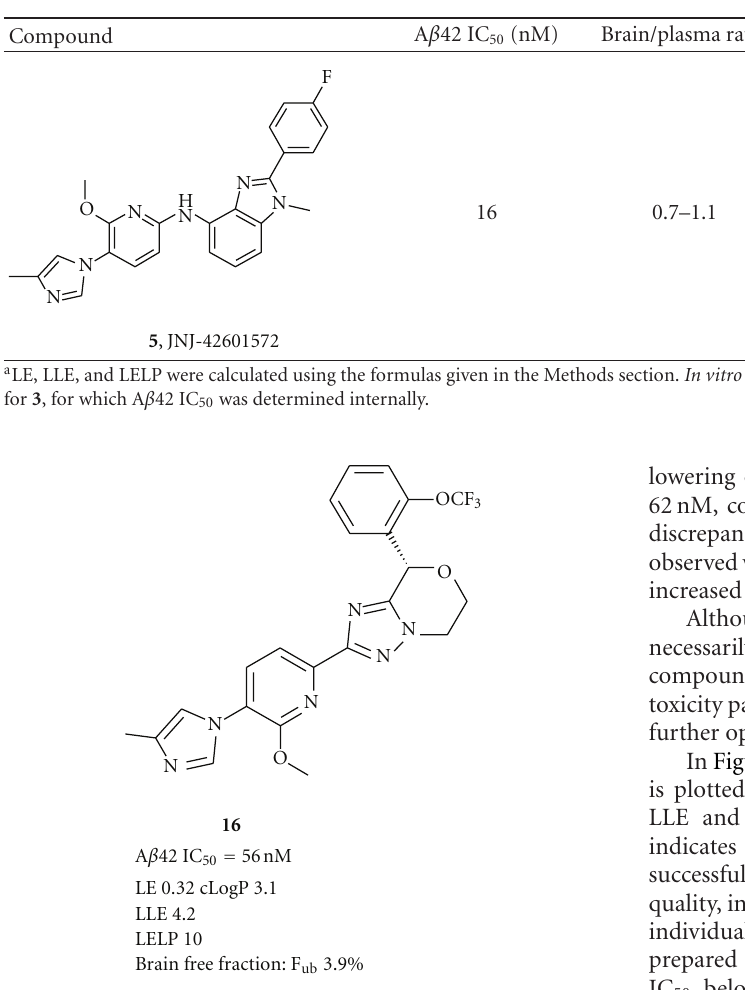
Figure 4: “Next generation”